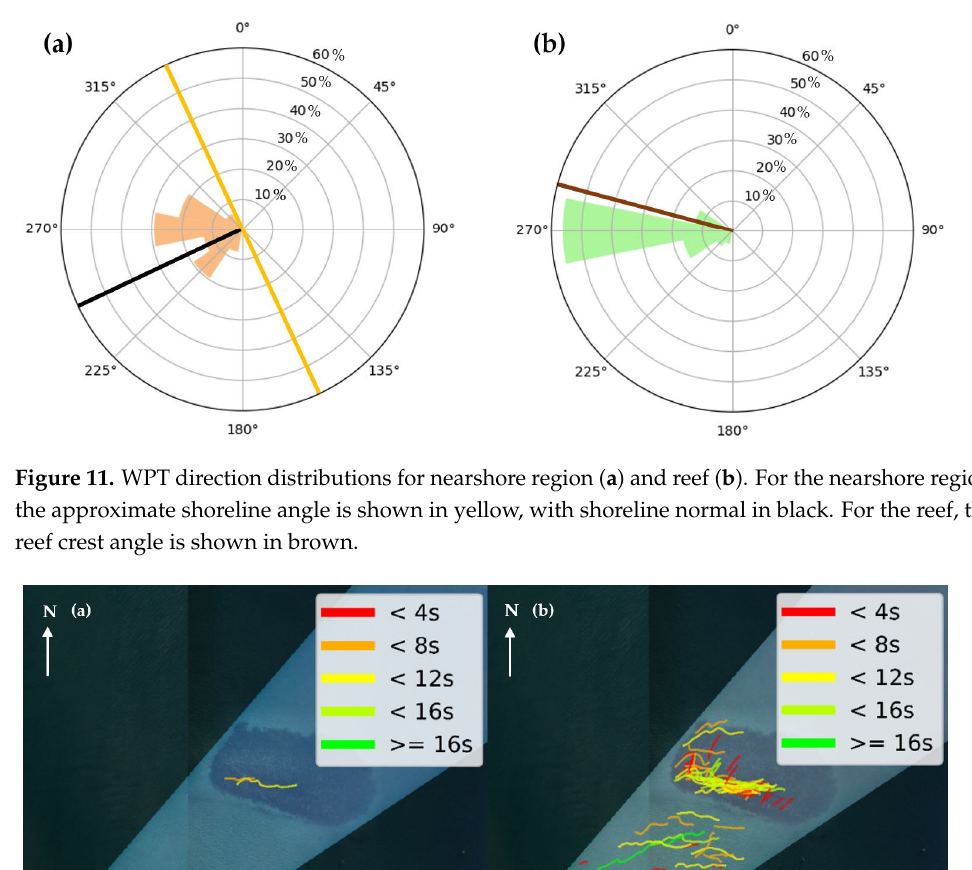
Figure 12. Durations maps for tracked rides between 8:30am and 8:40am at tide = 1.86 m LAT ( a ) and 12:10 pm and 12:20 pm at tide = 0.96 m LAT ( b ).